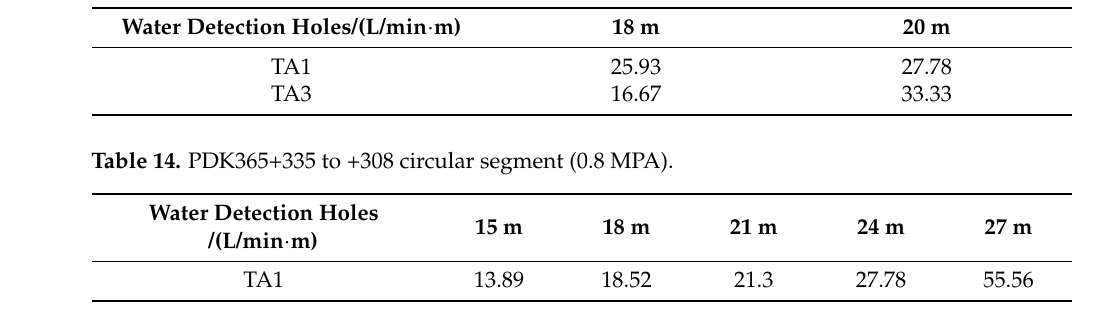
Table 15. ZDDK365+320 to +292.5 Circulation section (1.2 MPA).